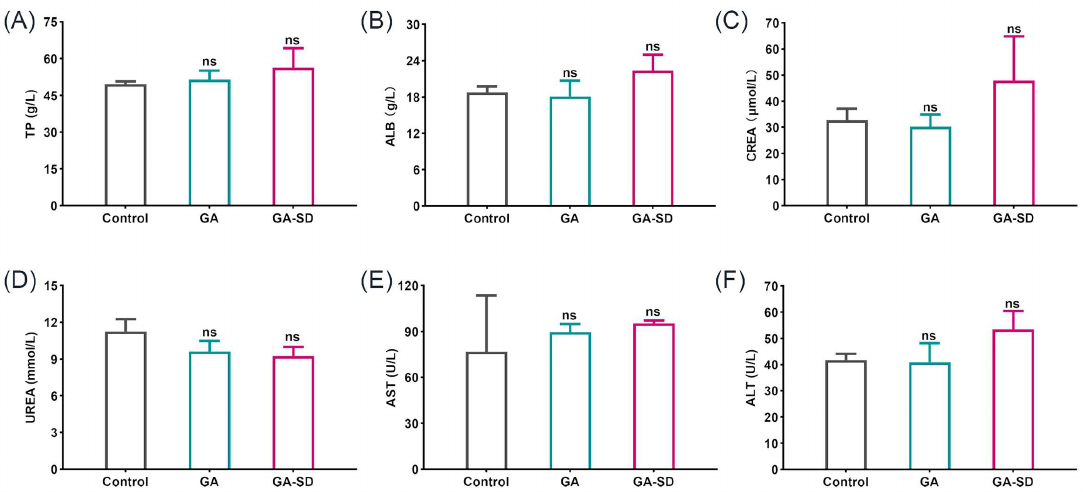
Figure 10. ( A – F ) Serum biochemical changes of drugs treated mice. Values are presented as the mean ± SD ( n = 3). ns p > 0.05 vs. control group. Biochemical index reference values: TP (57.1 ± 19.4 g/L), ALB (22.4 ± 5.1 g/L), CREA (50.4 ± 35.4 µmol/L), UREA (8.99 ± 2.89 mmol/L), AST (<400 U/L), and ALT (<400 U/L).